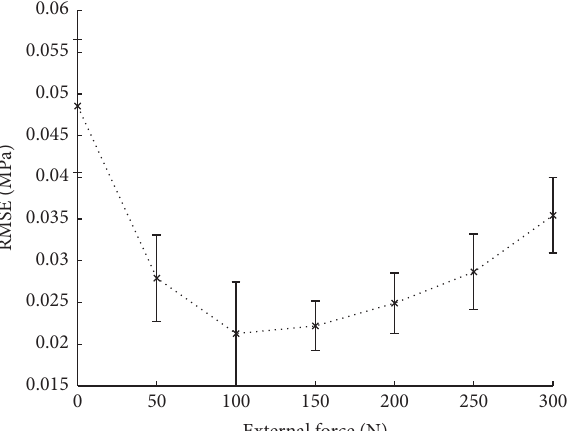
Figure 14: Root mean square error (RMSE) at all evaluated frequencies and external forces.